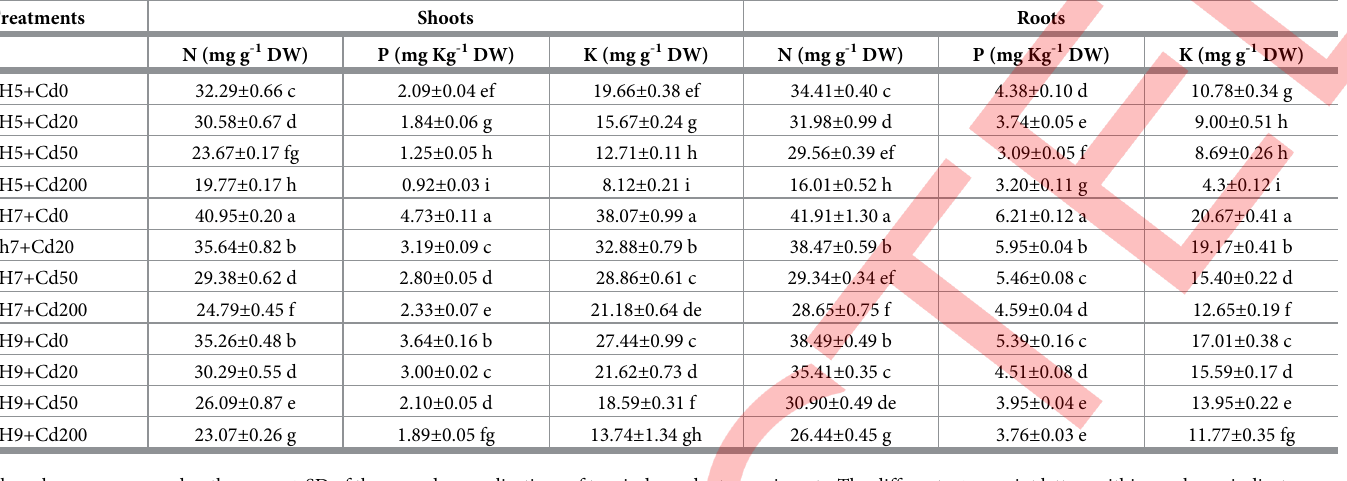
Table 1. Effect of pH and Cd on nitrogen (N), phosphorus (P), potassium (K) in shoot and root samples of the wheat plants grown under Cd-contaminated growth media with three different levels of pHs. Treatments